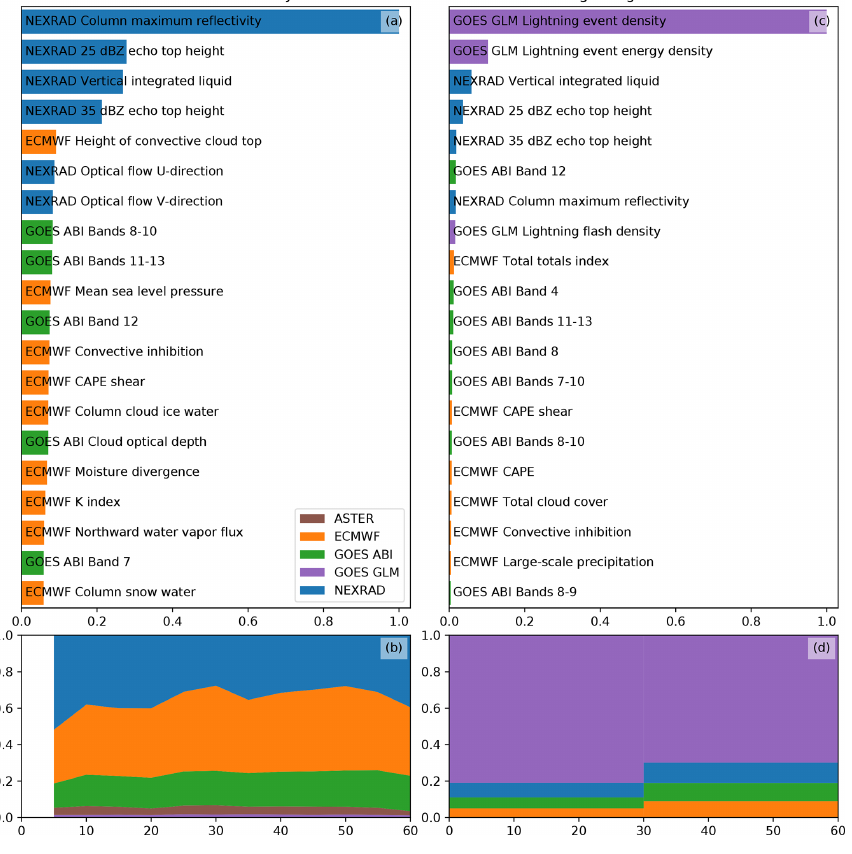
Figure 6. The importances of the various features and data sources for the MAXZ (a, b) and LIGHTNING-OCC (c, d) predictands according to LightGBM. The top panels show the 20 most important source variables for each predictand. The importances have been summed from all features and time steps and normalized such that the most important variable is scaled to 1. The bottom panels show the total importances of the various data sources as a function of lead time (in panel b ) or the prediction time range (in panel d